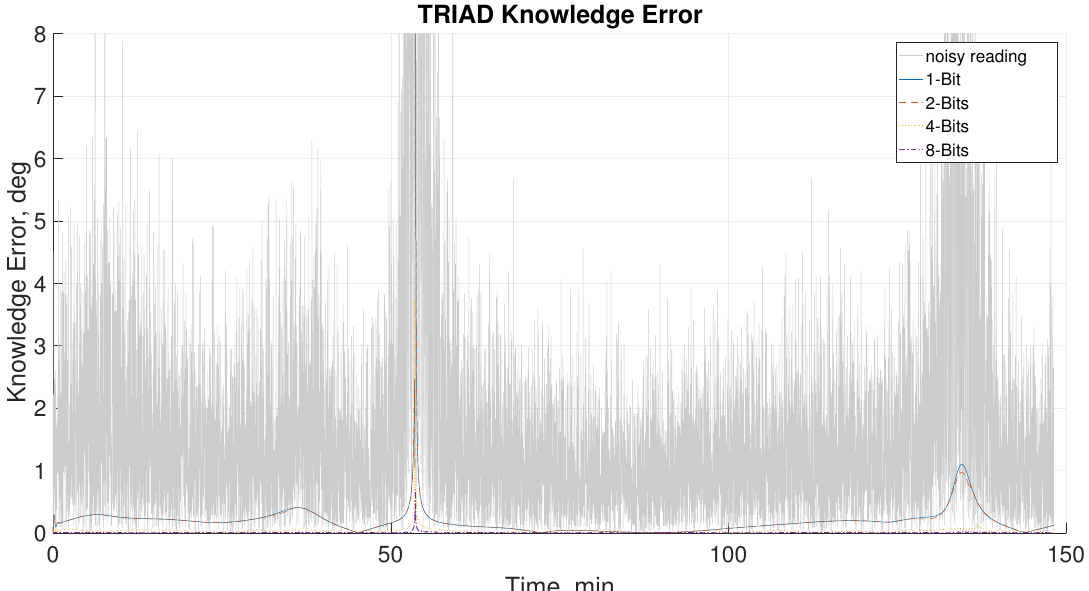
Figure 14. Knowledge error from TRIAD algorithm subjected to noise and knowledge error of different readout configura- tions with magnetometer noise removed.